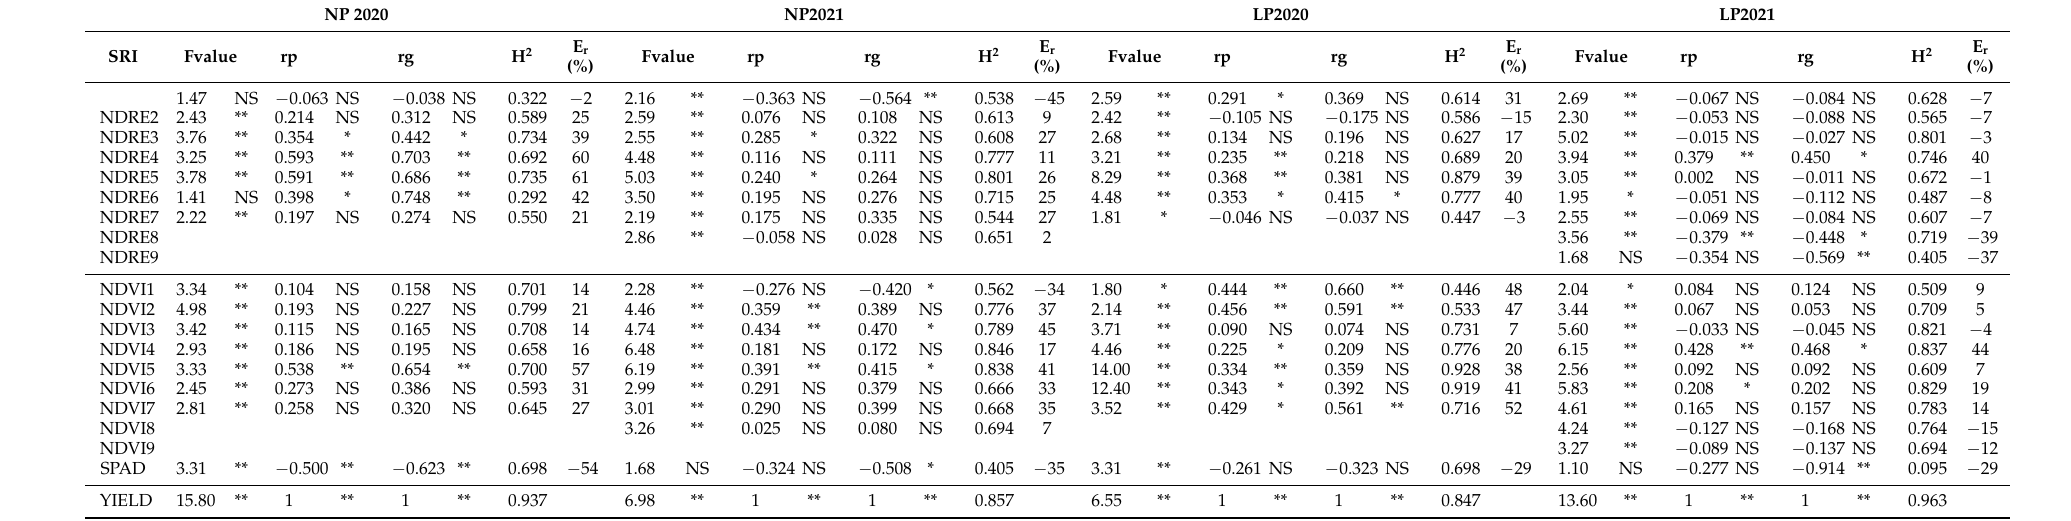
Table 6. ANOVA F values to verify genetic variation among lines for each SRI, phenotypic correlation(rp) and genotypic correlation(rg) between sesame yield and SRIs, broad-sense heritability on a line mean basis (H2) all on different monitoring dates across growing conditions and cropping years (NP20, NP21, LP20, LP21). Relative efficiency of indirect selection (E r ) in SRIs vs. direct selection in yield expressed in